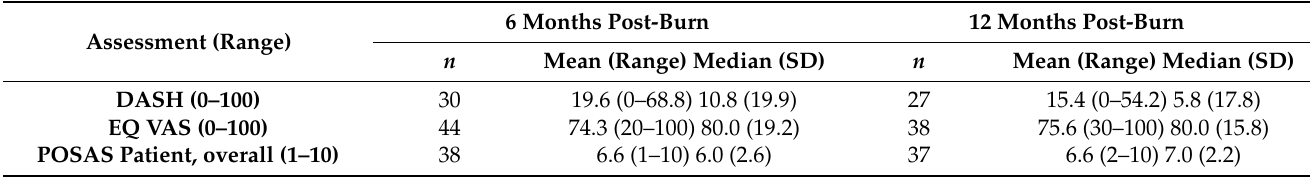
Table 1. Assessments at 6 and 12 months post-burn